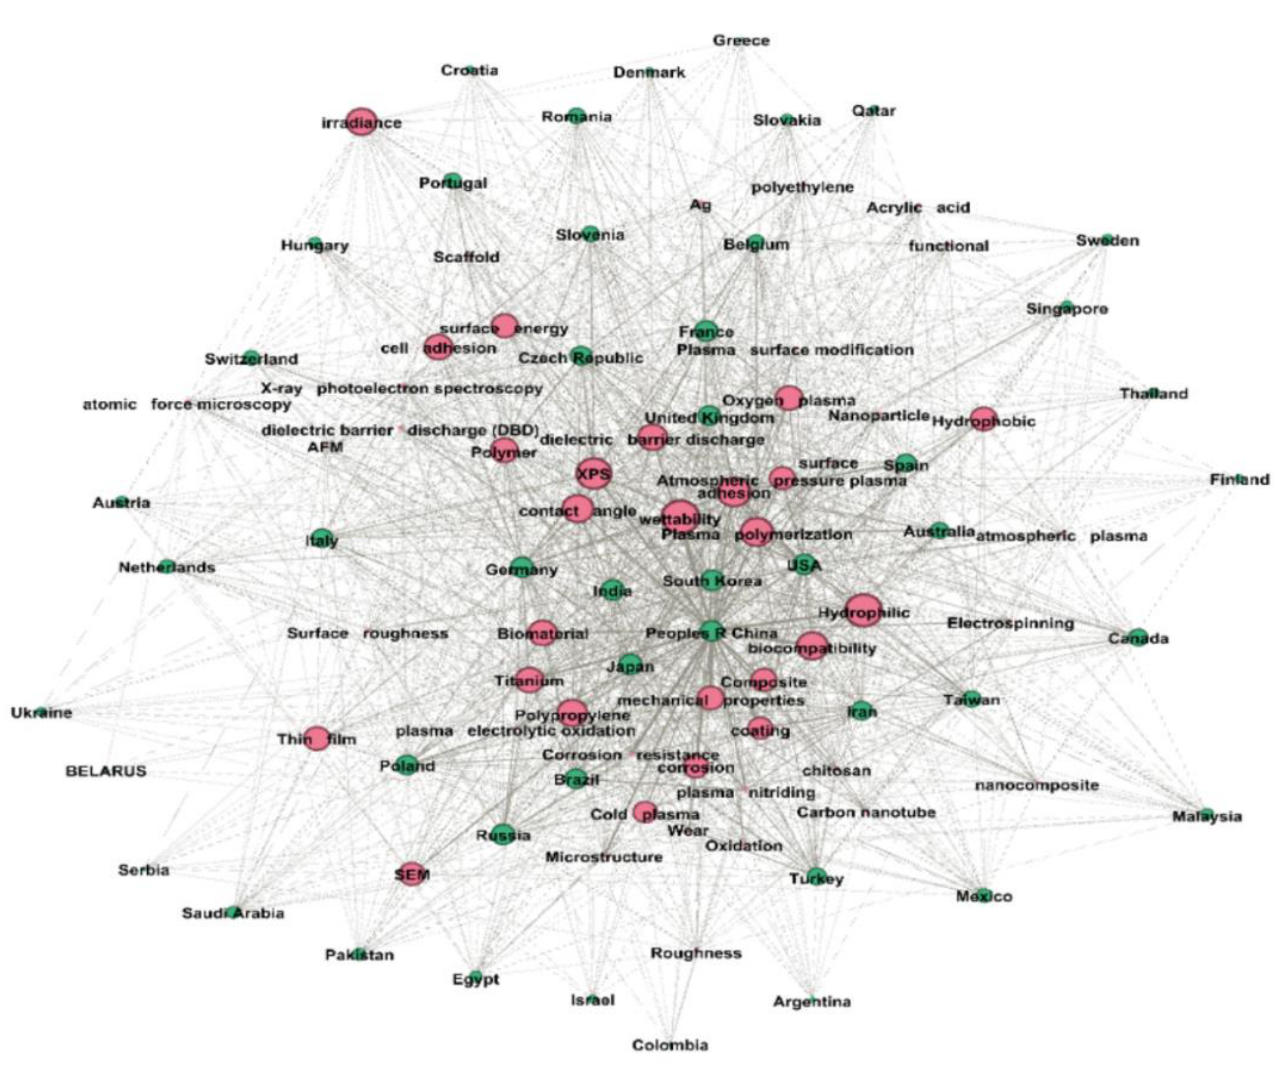
Figure 5. Plasma surface treatment related country (green nodes) – author keyword (red nodes) network.